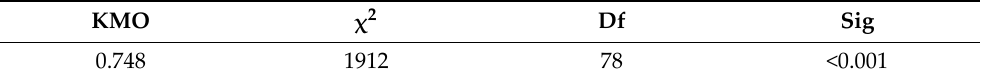
Table 5. KMO measure of sampling adequacy and Bartlett’s test of sphericity. KMO χ 2 Df Sig 0.748 1912 78